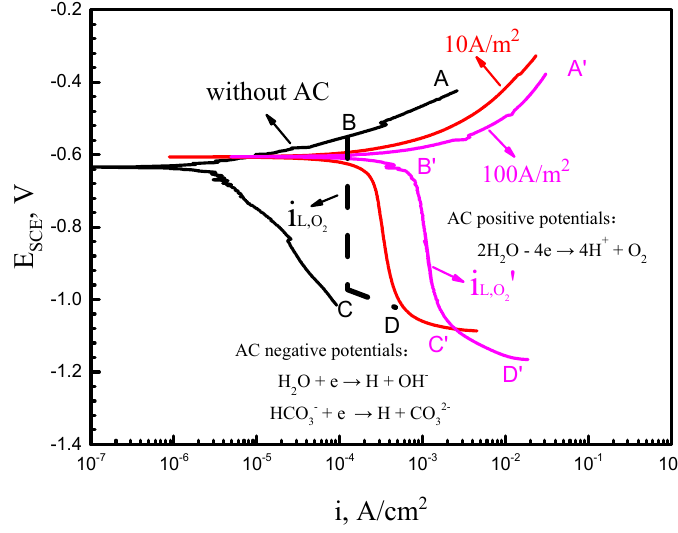
Figure 13. The effect of AC on the cathodic reaction of the X70 steel in simulated seawater.